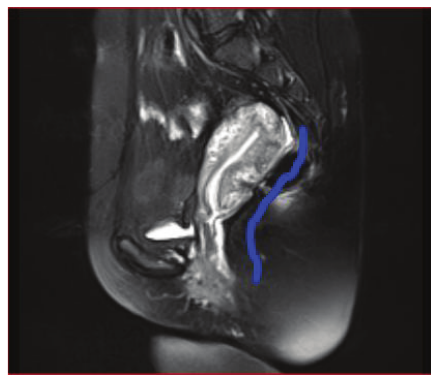
Figure 2: MRI appearance of the pelvis with uterus at 12 months